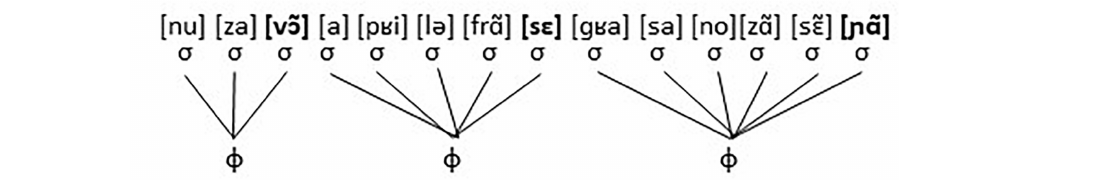
FIGURE 3 | The grammatical structure (above) does not coincide with the phonological structure